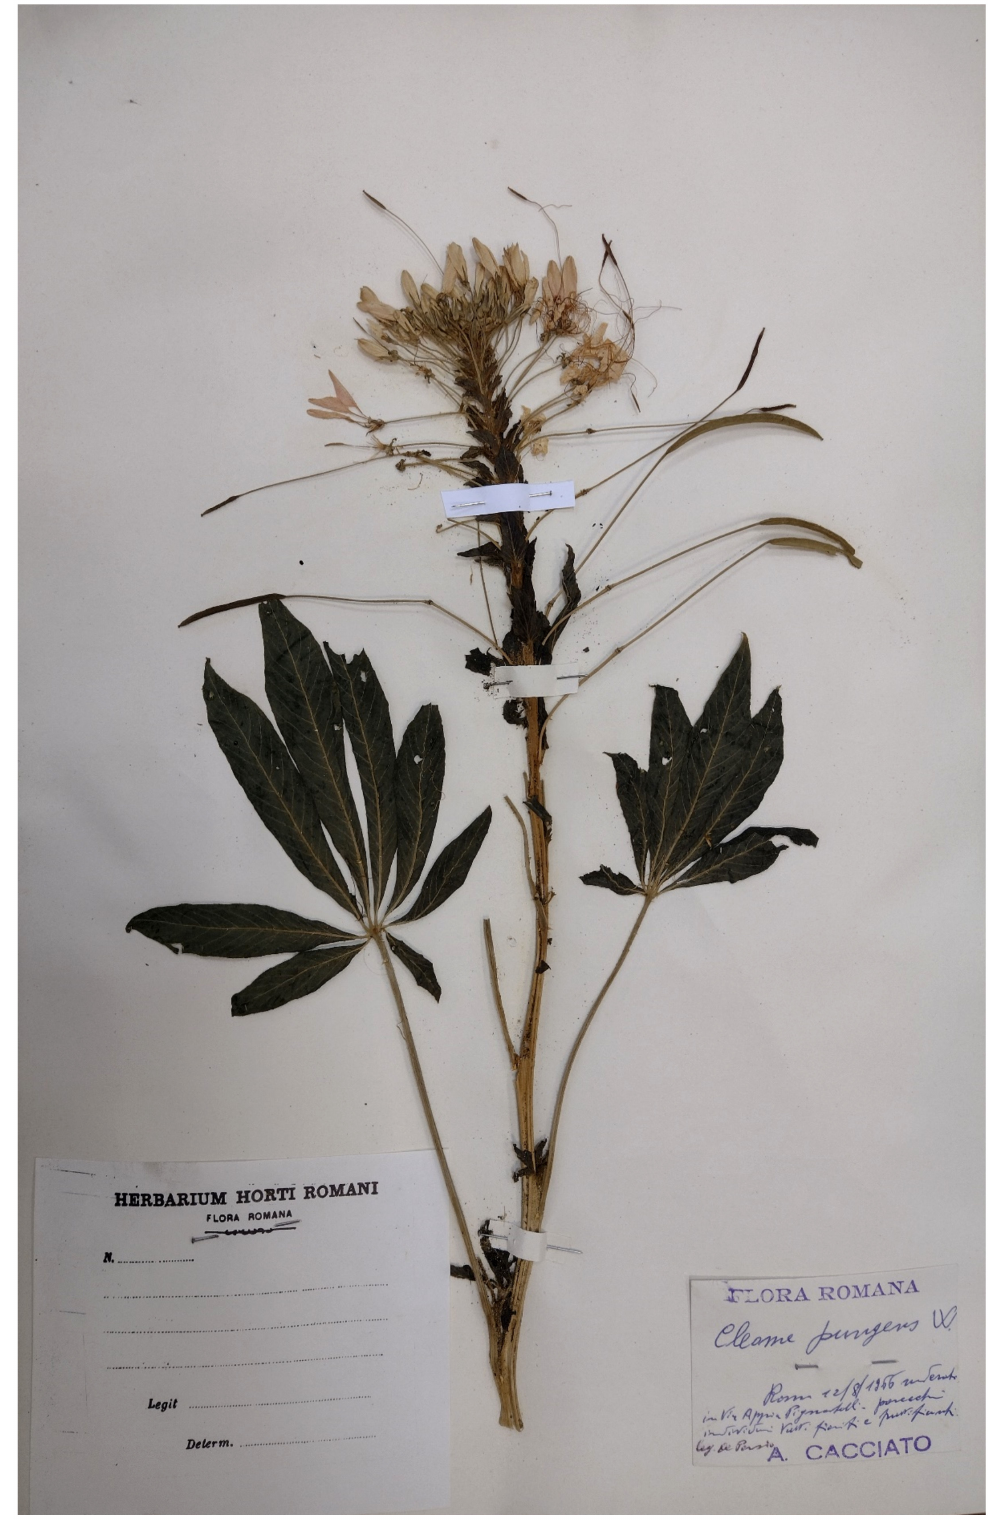
Figure 70. Specimen of Tarenaya spinosa collected along Appia Pignatelli street in august 1965 (RO- Herbarium Romano